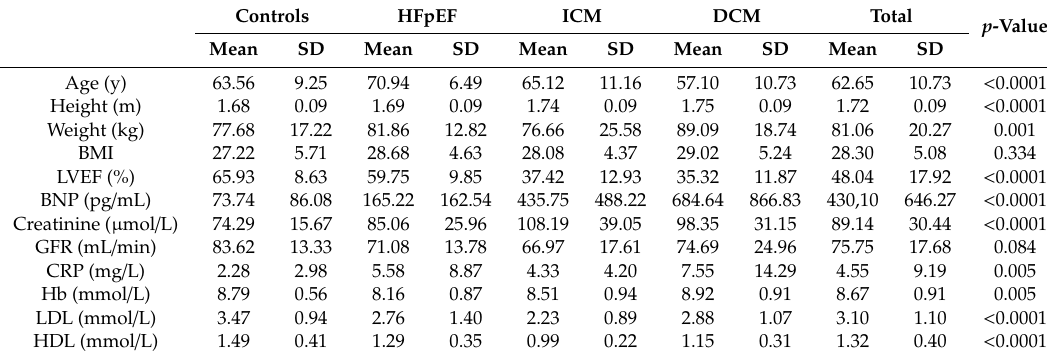
Table 1. Baseline Characteristics.